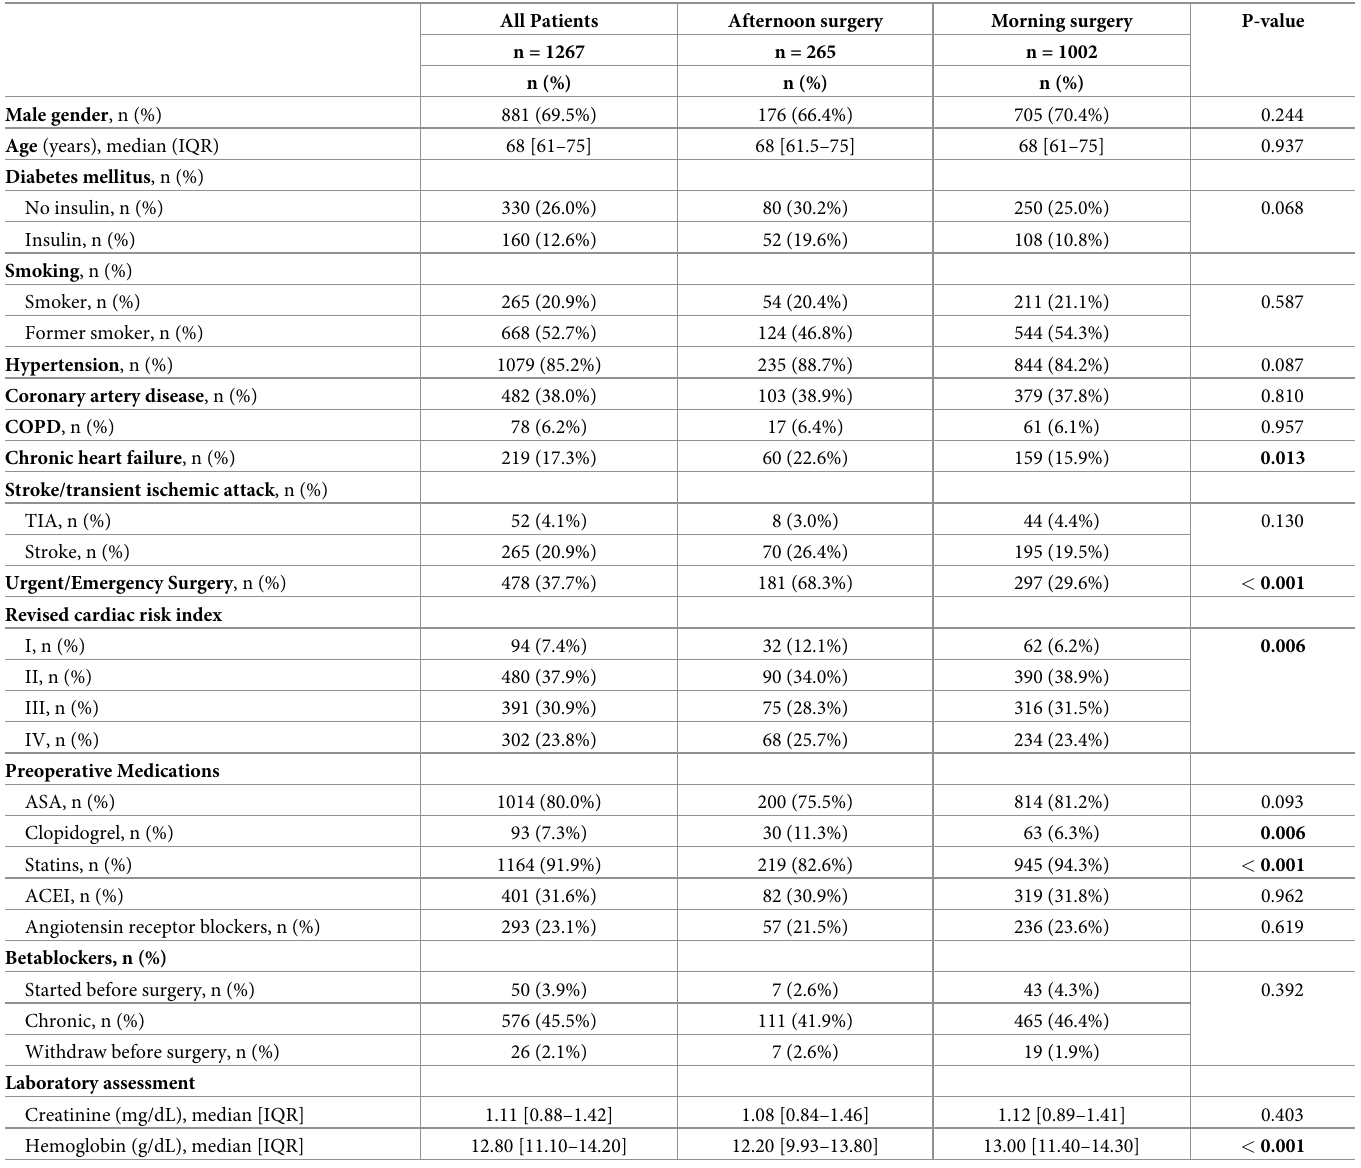
Table 1. Baseline characteristics of the 1,267 patients in the cohort.